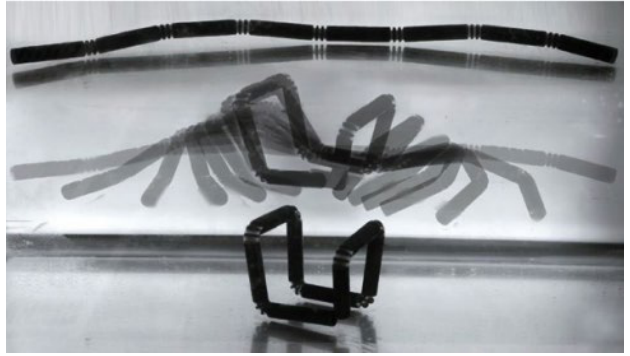
Figure 8. Self-folding line [90].